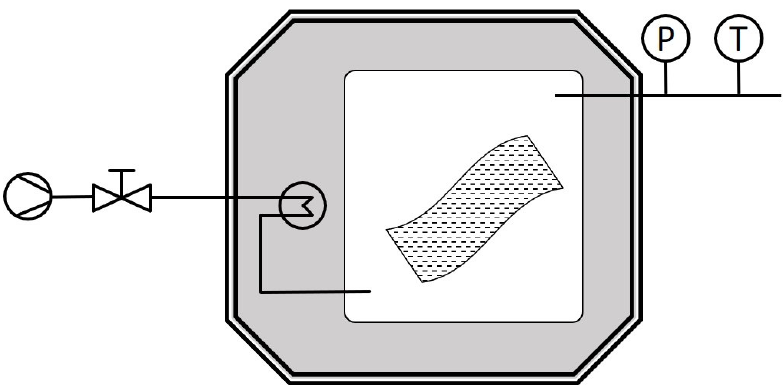
Figure 1. Experimental device employed for the decontamination of film